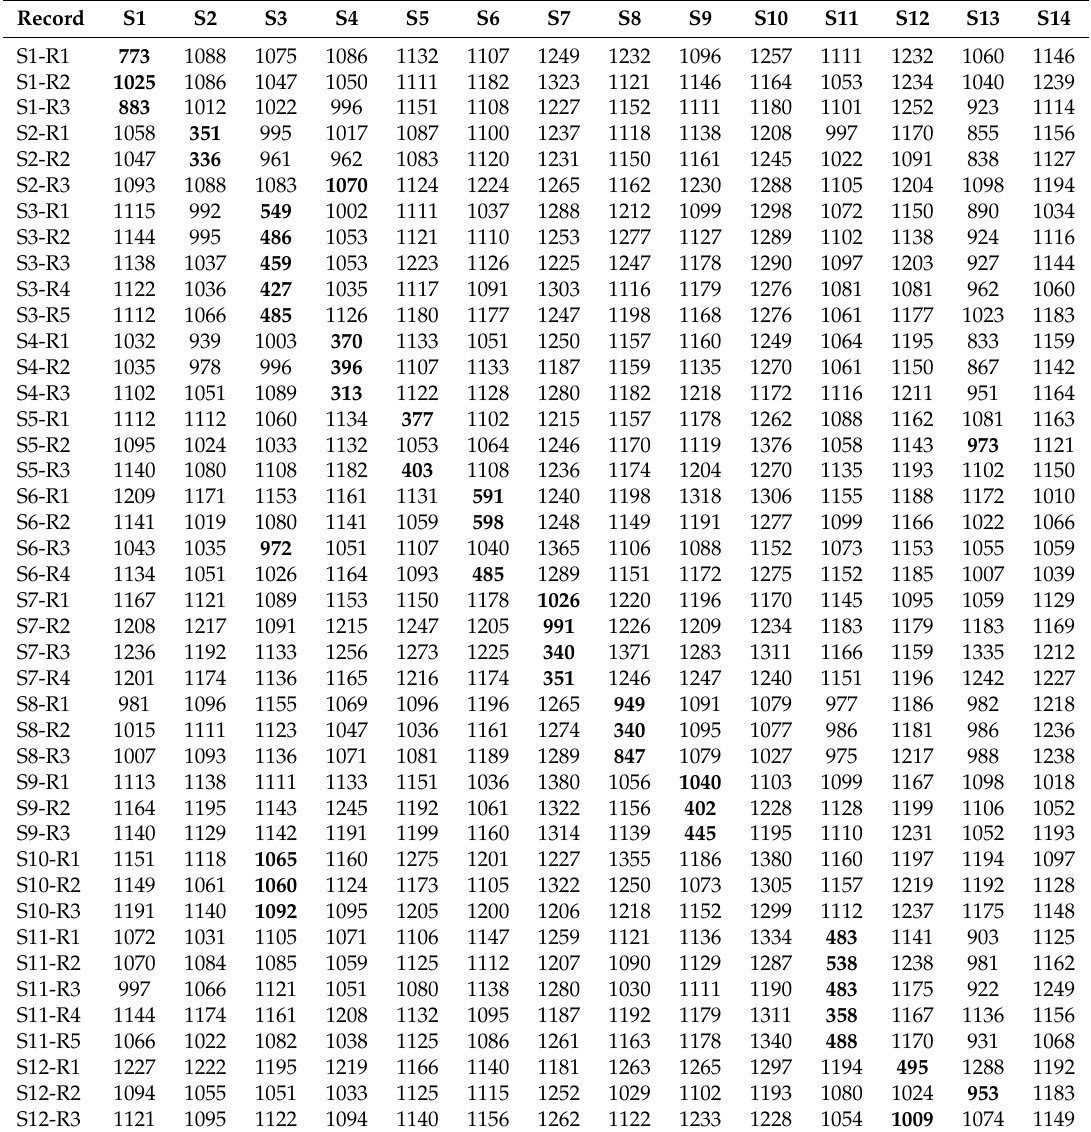
Table 3. Audio fingerprints